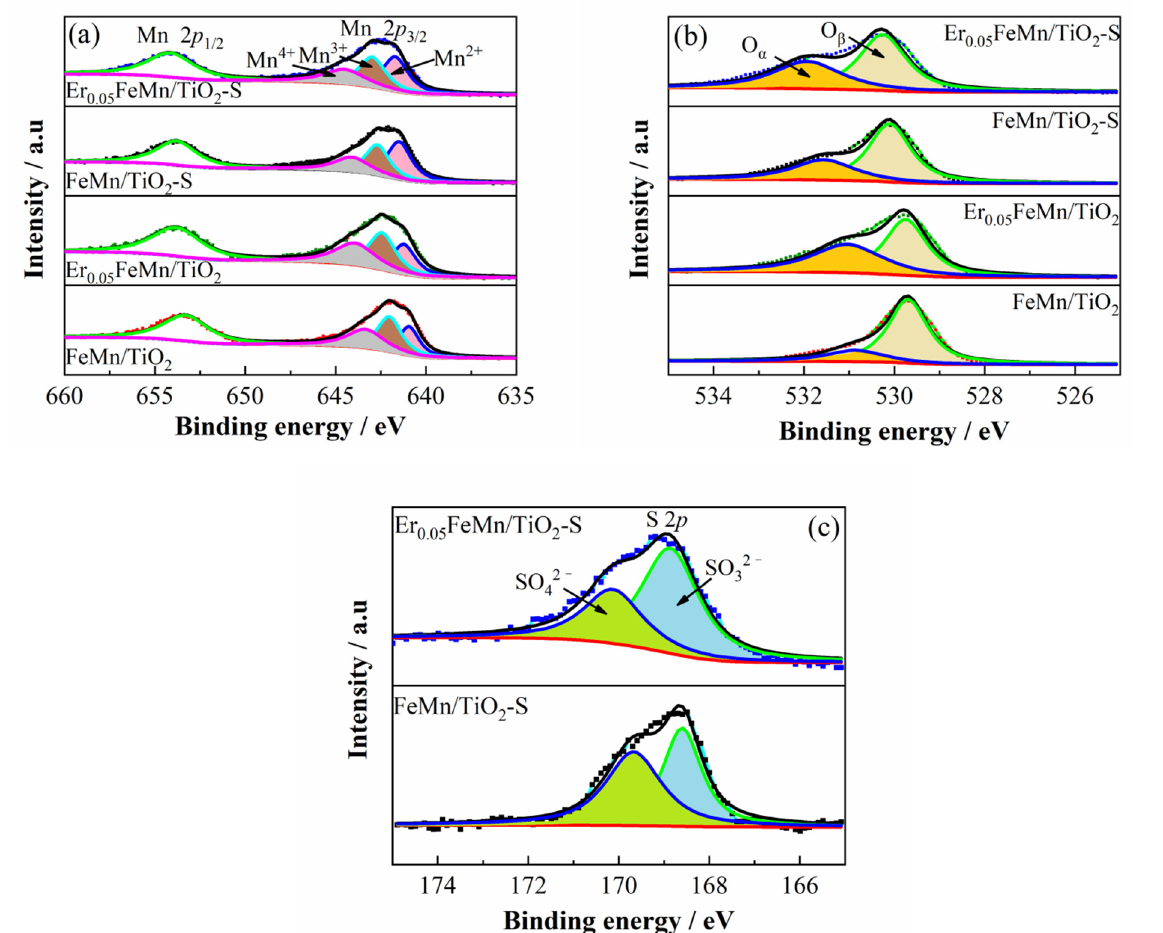
Figure 5. XPS spectra of Mn 2 p ( a ), O 1 s ( b ) and S 2 p ( c ) over FeMn/TiO 2 and Er 0.05 FeMn/TiO 2 catalysts.